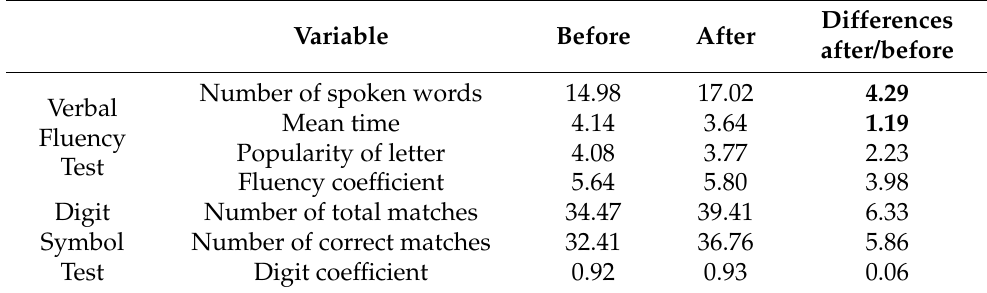
Table 4. Results of the Verbal Fluency Test and the Digit Symbol Test (bold statistically significant features).